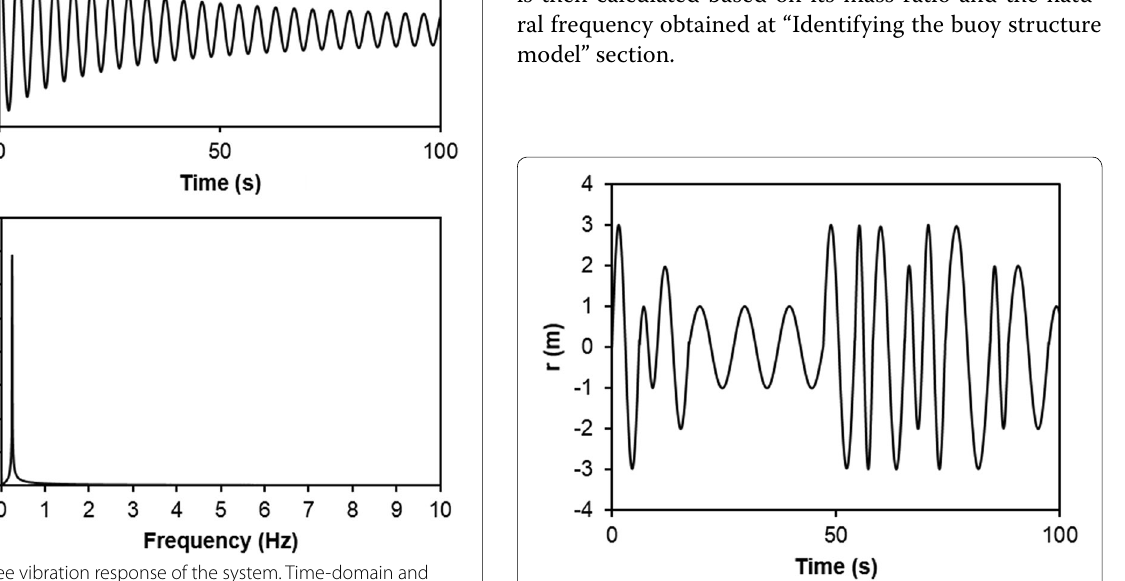
Fig. 12 The input multi-sine signal. Linear motion of the slider in STMD is input as a multi-sinusoidal signal for system